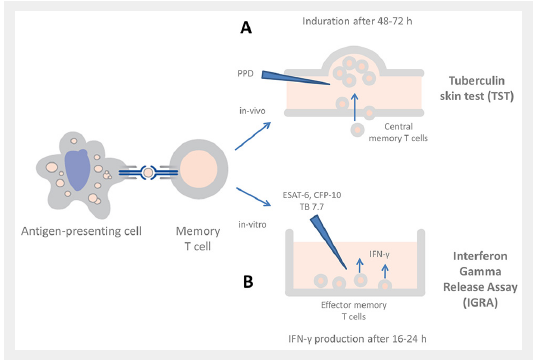
The current immunodiagnostic tests in clinical use for the diagnosis of tuberculosis (adapted from: Andersen P, Munk ME, Pollock JM, Doherty TM. Specific immune-based diagnosis of tuberculosis. Lancet. 2000;356(9235):1099–104, with permission from Elsevier). Exposure to M. tuberculosis leads to uptake by antigen-presenting cells and primes antigen-specific T cells in the local lymph node. (A) In the TST, after re-stimulation with PPD, mycobacterial-specific central memory T cells infiltrate the skin at the injection site and cause a palpable induration. (B) In IGRAs, blood is stimulated in vitro with ESAT-6, CFP-10 and (in the QFT-GIT only) TB 7.7, resulting in IFN-γ production by circulating effector memory T cells, which is measured by ELISA or